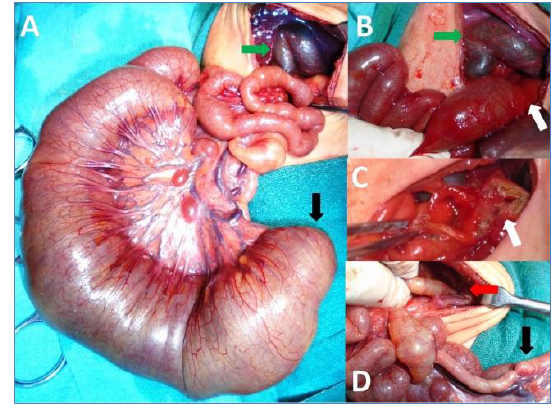
Figure 2: Intra-operative picture showing duplication of gallbladder (green arrow) with ileal atresia (A); pyloric atresia (white arrow) and gallbladder duplication (green arrow) (B); Heineke–Mickulicz pyloroplasty (C); colonic atresia (red arrow) and terminal ileum (black arrow)